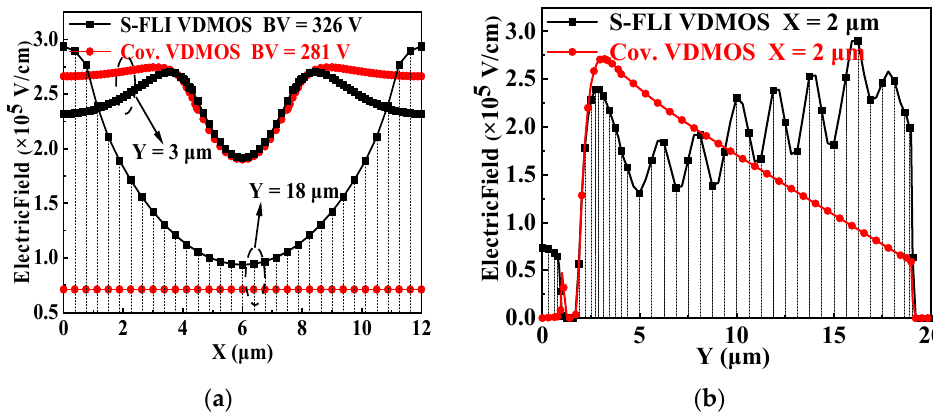
Figure 3. ( a ) Lateral electric field distributions for the conventional Si VDMOS and S-FLI VDMOS with Rings of 7: Y = 3 μ m, Y = 18 μ m and ( b ) Vertical electric field distributions for the conventional Si VDMOS and S-FLI VDMOS with Rings of 7: X = 2 μ m.